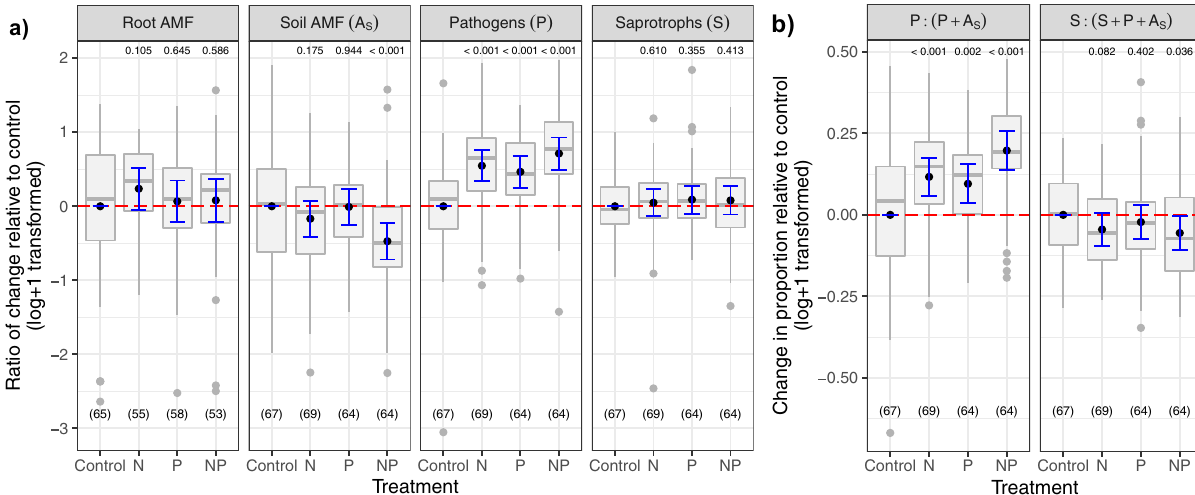
Fig. 1 Responses by fungal guilds to nitrogen (N), phosphorus (P), and N + P addition across grasslands. a Colonization by AMF in roots based on microscopy (Root AMF), and soil abundance of AMF (Soil AMF, A s ), putative pathogens (P), and saprotrophs (S) based on sequence numbers in comparison to the control plots. b The P:(P + A S ) quanti fi es shifts in pathogen to mutualist ratios, and the S:(S + P + A S ) highlights shifts in the producer and decomposer food webs 61 and how nutrient addition changes the relative abundance of fungi associated with living and dead plants. The black dot indicates the estimated mean effect, the blue bars the 0.95 con fi dence interval of the mean, while the gray bar and dots represent the boxplot and corresponding outliers of the partial residuals. Boxplots denote median value (black bar), with hinges (gray) representing the 25th and 75th percentiles, and lines extending to the 1.5× interquartile range. Numbers at the bottom indicate the number of observations included in each treatment. Numbers at the top indicate the p -value based on the two-sided t-statistic of the estimated treatment mean effect compared to the control